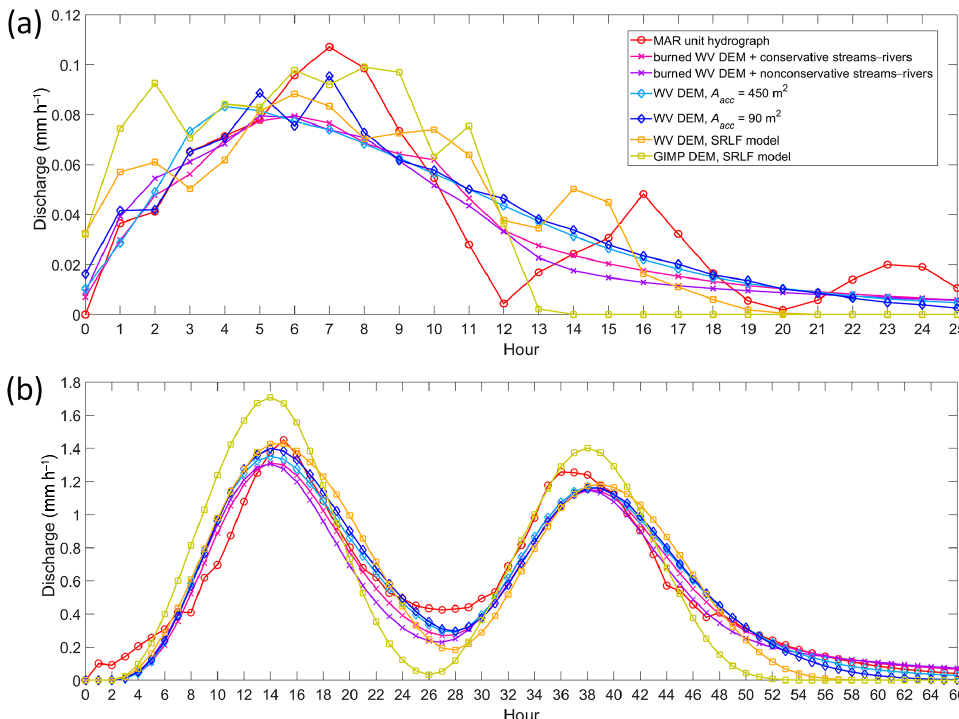
Figure 6. (a) Unit hydrographs (UHs) and (b) simulated direct hydrographs at the terminal moulin of the Rio Behar catchment, as modeled by different data sources and methods. The MAR UH is calibrated from effective MAR melt and measured supraglacial river discharge (Fig. 2). The rescaled width function (RWF) and surface routing and lake-filling (SRLF) UHs are obtained by calibrating open-channel and interfluve velocities to optimally match the MAR